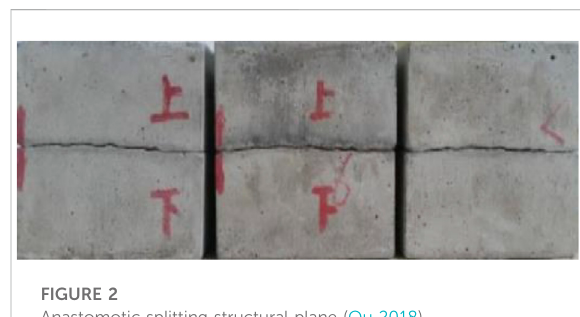
FIGURE 2 Anastomotic splitting structural plane (Qu